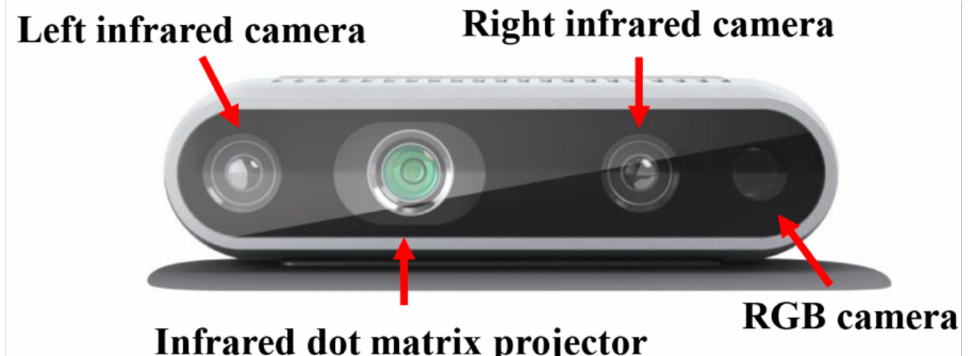
Figure 3. Intel ® RealSense™ Depth Camera